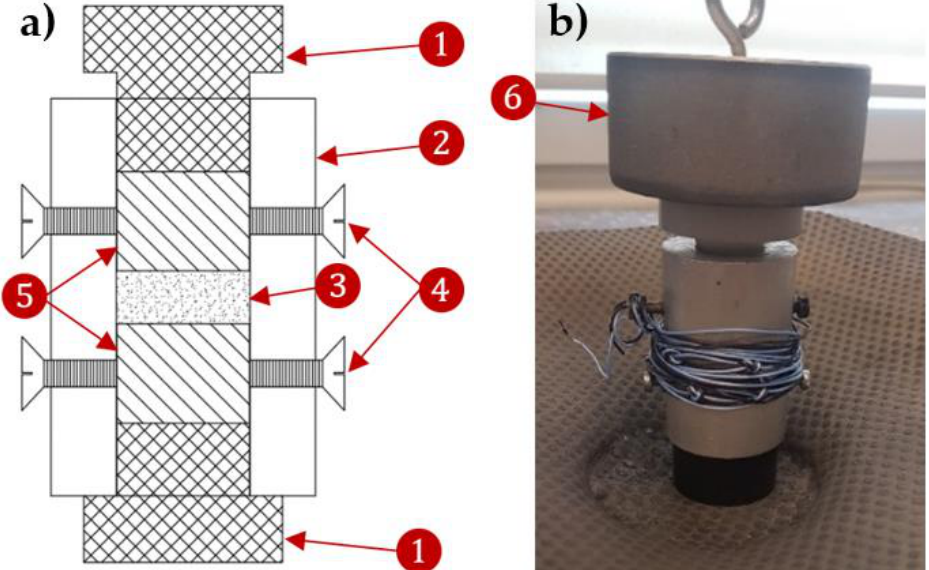
Figure 10. Installation for compaction of a sample of non-cohesive soil as part of the SHPB test with markings of the crucial components: ( a ) schematic diagram and ( b ) actual view ❶ – ❻ (reprinted from Ref. [60]).